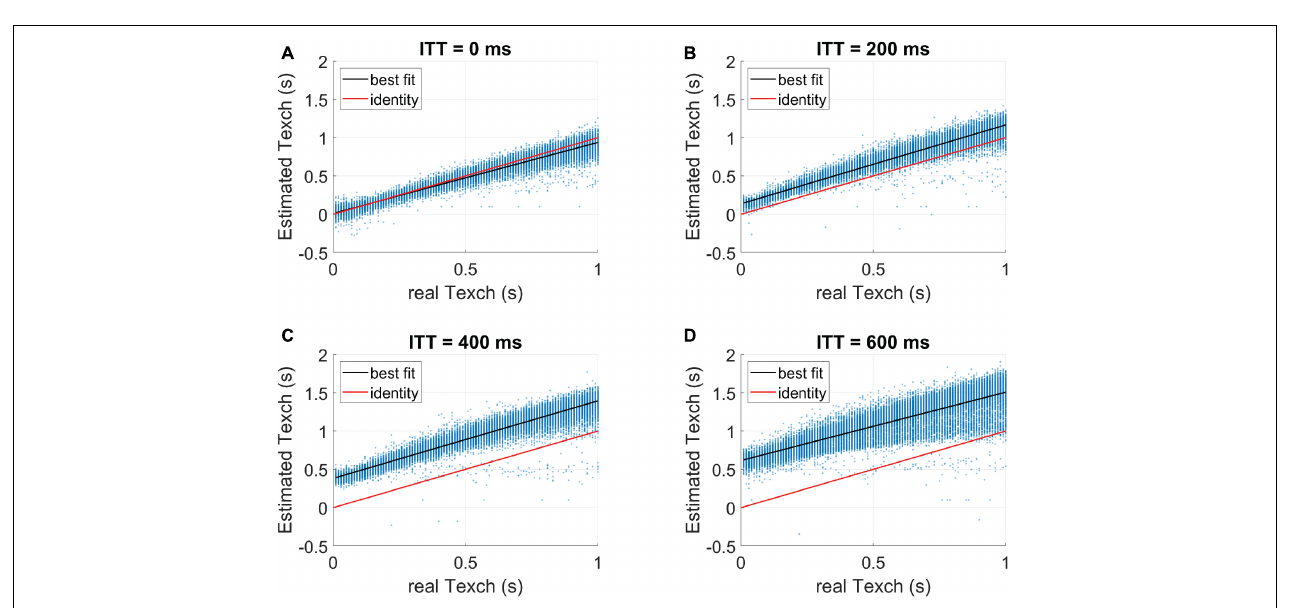
FIGURE 4 | Texch percentage deviation error resulting from the two-compartment model. Test cases were generated with variable ITT values. As can be seen, even a small ITT value of 100 ms results in an overestimation of Texch, especially for the lower Texch values. The estimated apparent Texch values may correspond to a sum of the underlying true Texch and true ITT and thus result in an overestimation of the Texch parameter.